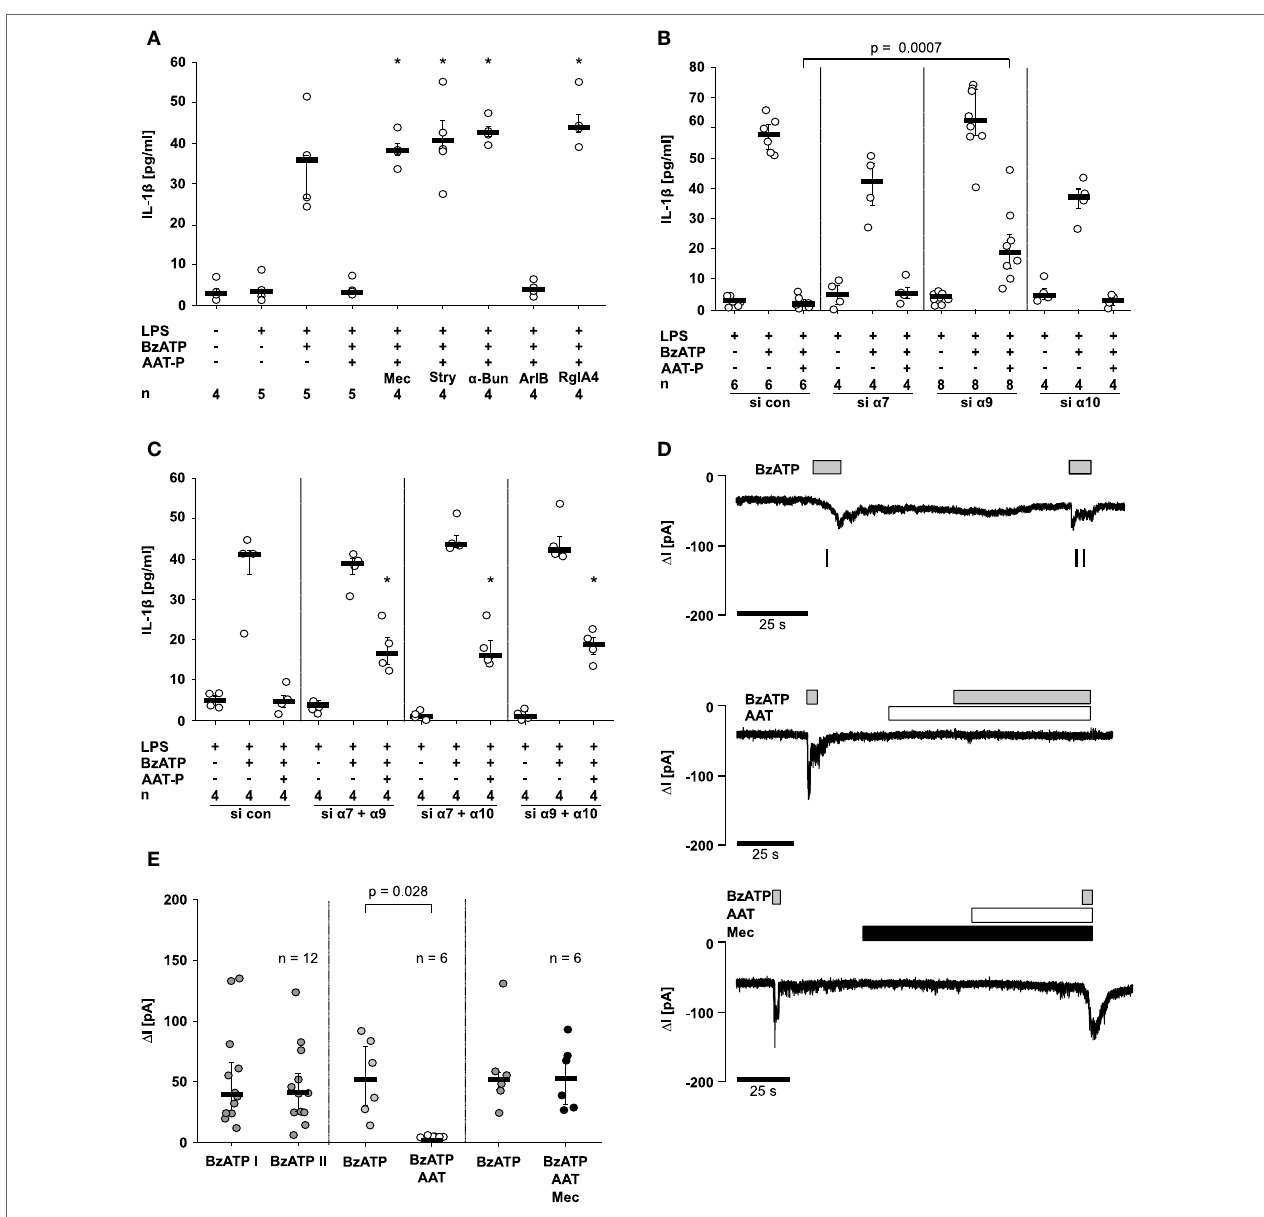
FigUre 5 | Alpha-1 antitrypsin (AAT) signaling involves nicotinic acetylcholine receptors (nAChR) and inhibits P2X7 receptor function. Lipopolysaccharide (LPS)-primed U937 cells were stimulated with 2 ′ (3 ′ )- O -(4-Benzoylbenzoyl)adenosine-5 ′ -triphosphate (BzATP) in the presence or absence of Prolastin ® (AAT-P, 1 mg/ml). (a–c) Interleukin (IL)-1 β released to the supernatant was measured after 30 min. (a) Nicotinic antagonists mecamylamine (Mec), α -bungarotoxin ( α -Bun), strychnine (Stry), RgIA4, or ArIB [V11L, V16D] were added together with BzATP and AAT-P, * p ≤ 0.05 compared to cells treated with LPS, BzATP, and AAT-P. (B,c) Expression of nAChR subunits α 7, α 9, and α 10 was silenced by siRNA (si α 7, α 9, α 10). Cells were either transfected with a single siRNA (B) or